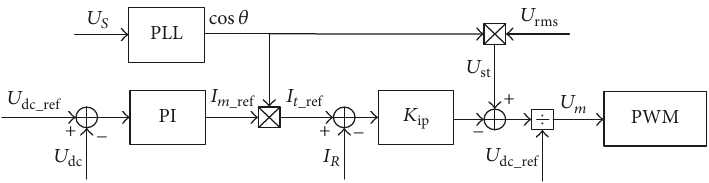
Figure 2: Double closed-loop control structure of voltage and